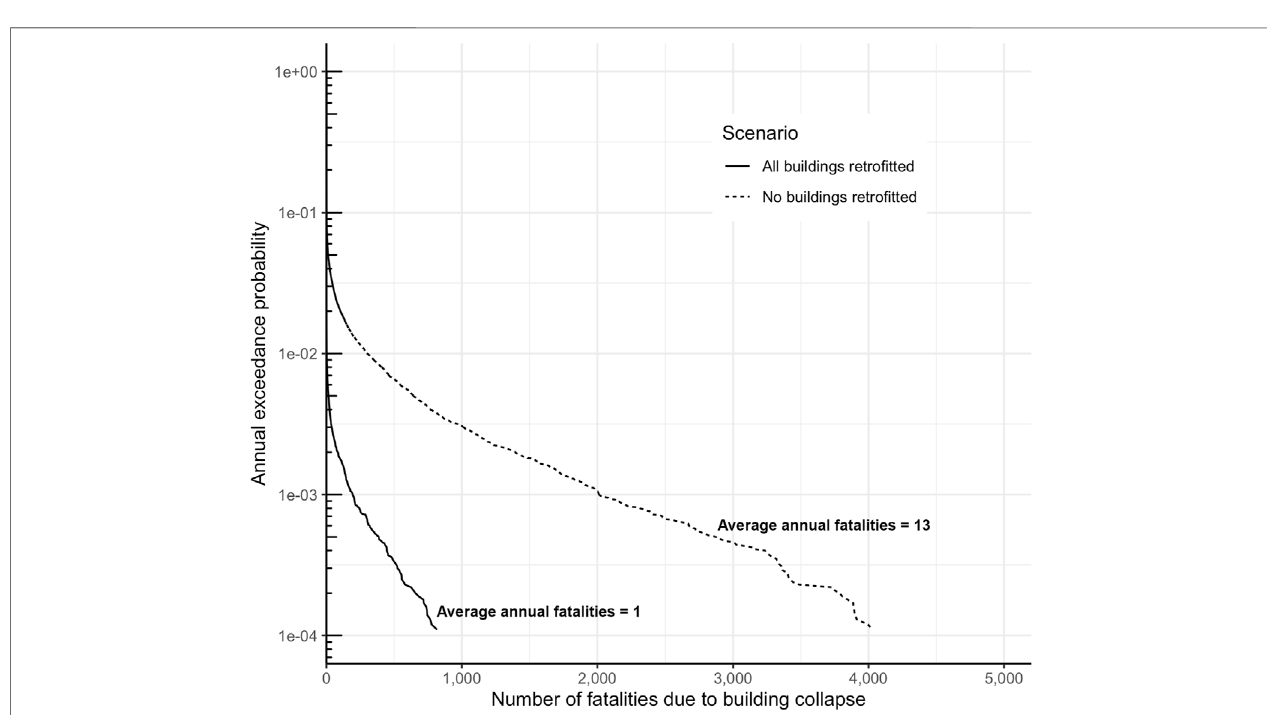
FIGURE 7 | Bene fi ts of extending Nepal ’ s school retro fi t program to 5,029 schools in the database in terms of the shift in the annual fatality exceedance curve.